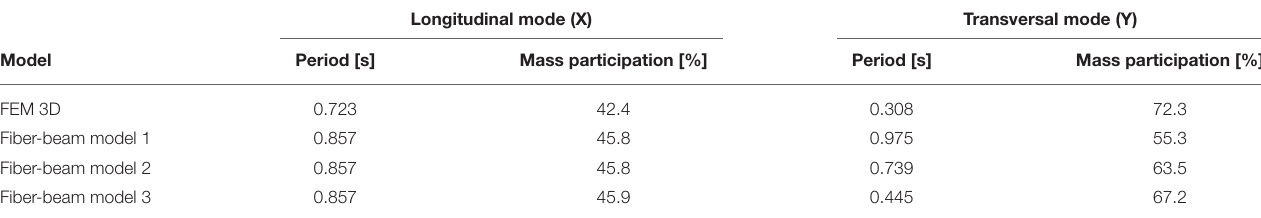
TABLE 2 | Comparison of principal vibration modes in longitudinal direction (X) and in transversal direction